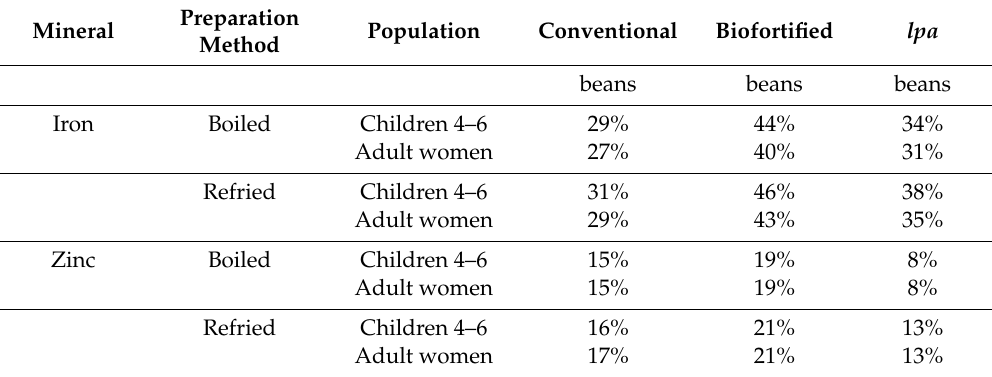
Table 7. Contribution of beans to iron and zinc EAR for children and adults for three groups (conventional, biofortified and lpa ) of beans and two preparation methods (boiled and